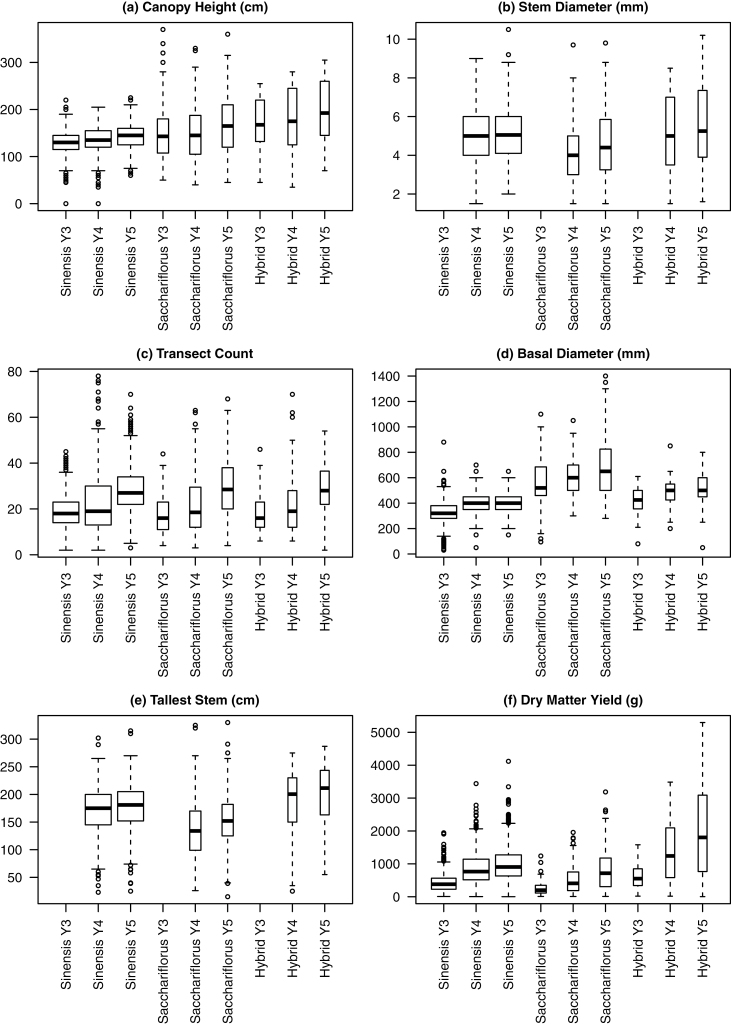
Summary of measured traits as boxplots for all plants by species (M. sinensis, M. sacchariflorus, and hybrid) and year (Y3, Y4, and Y5).